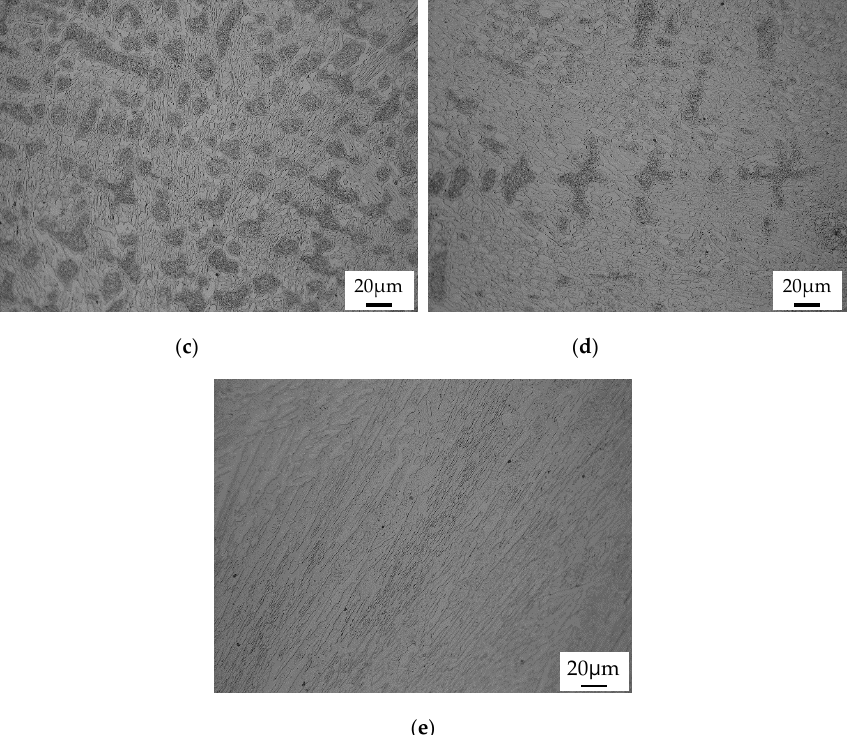
Metals 2021 , 11 , x FOR PEER REVIEW